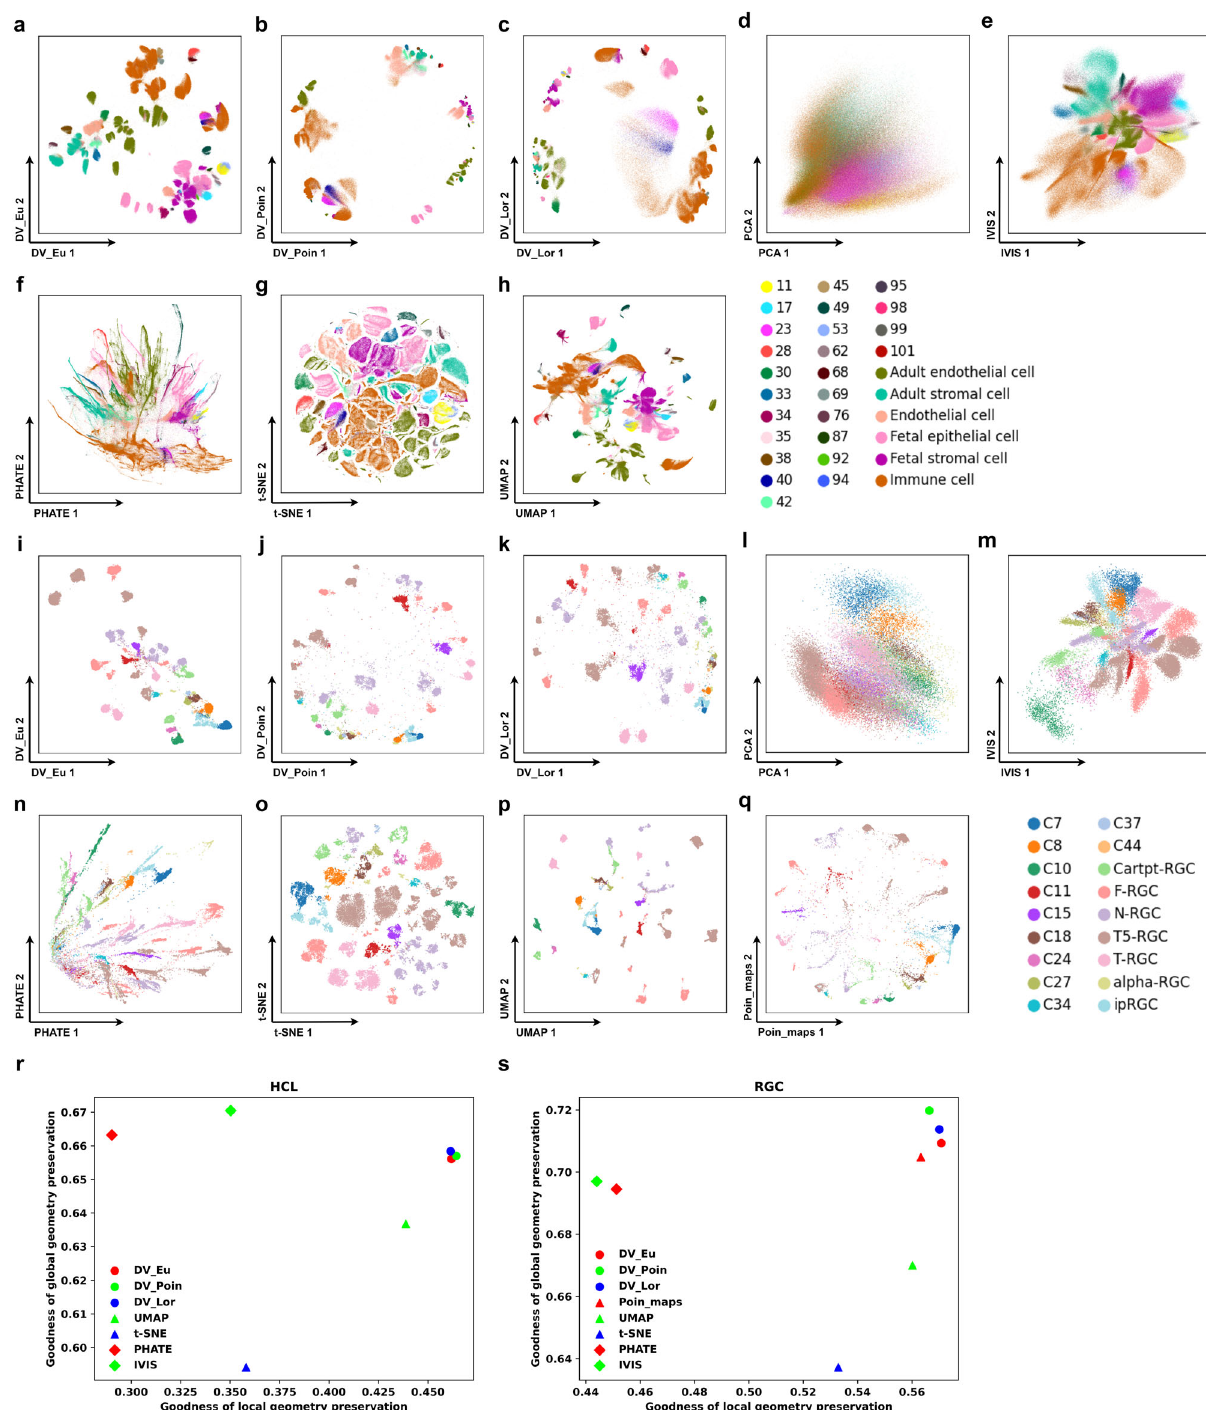
Fig. 2 DV preserves local and global structures in visualizing large static scRNA-seq data. a – q DV learns latent representations that provide excellent visualization of local and global structure, even in very large datasets. DV_Eu learns representations in the Euclidean space ( a , i ). DV_Poin learns representations in the hyperbolic space with Poincaré model ( b, j ). DV_Lor learns representations in the hyperbolic space with Lorentz model ( c , k ). 2-dimensional PCA ( d , l ), IVIS ( e , m ), PHATE ( f , n ), t-SNE ( g , o ), UMAP ( h , p ) and Poin_maps ( q ) representations for human cell landscape (HCL) (GSE134355) ( a – h ) and mouse retinal ganglion cells (RGC) (GSE137400) ( i – q ) with cells colored by major cell types. Quantify global/hierarchical and local structure preservation performance of HCL and RGC datasets ( r , s